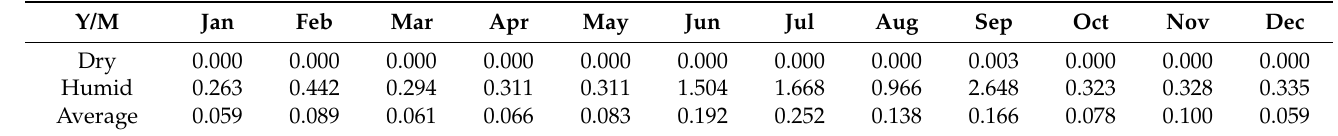
Table 3. Values of flow rate (m 3 /s) to estimate the hydrologic year. Y/M is the abbreviation of year/month.